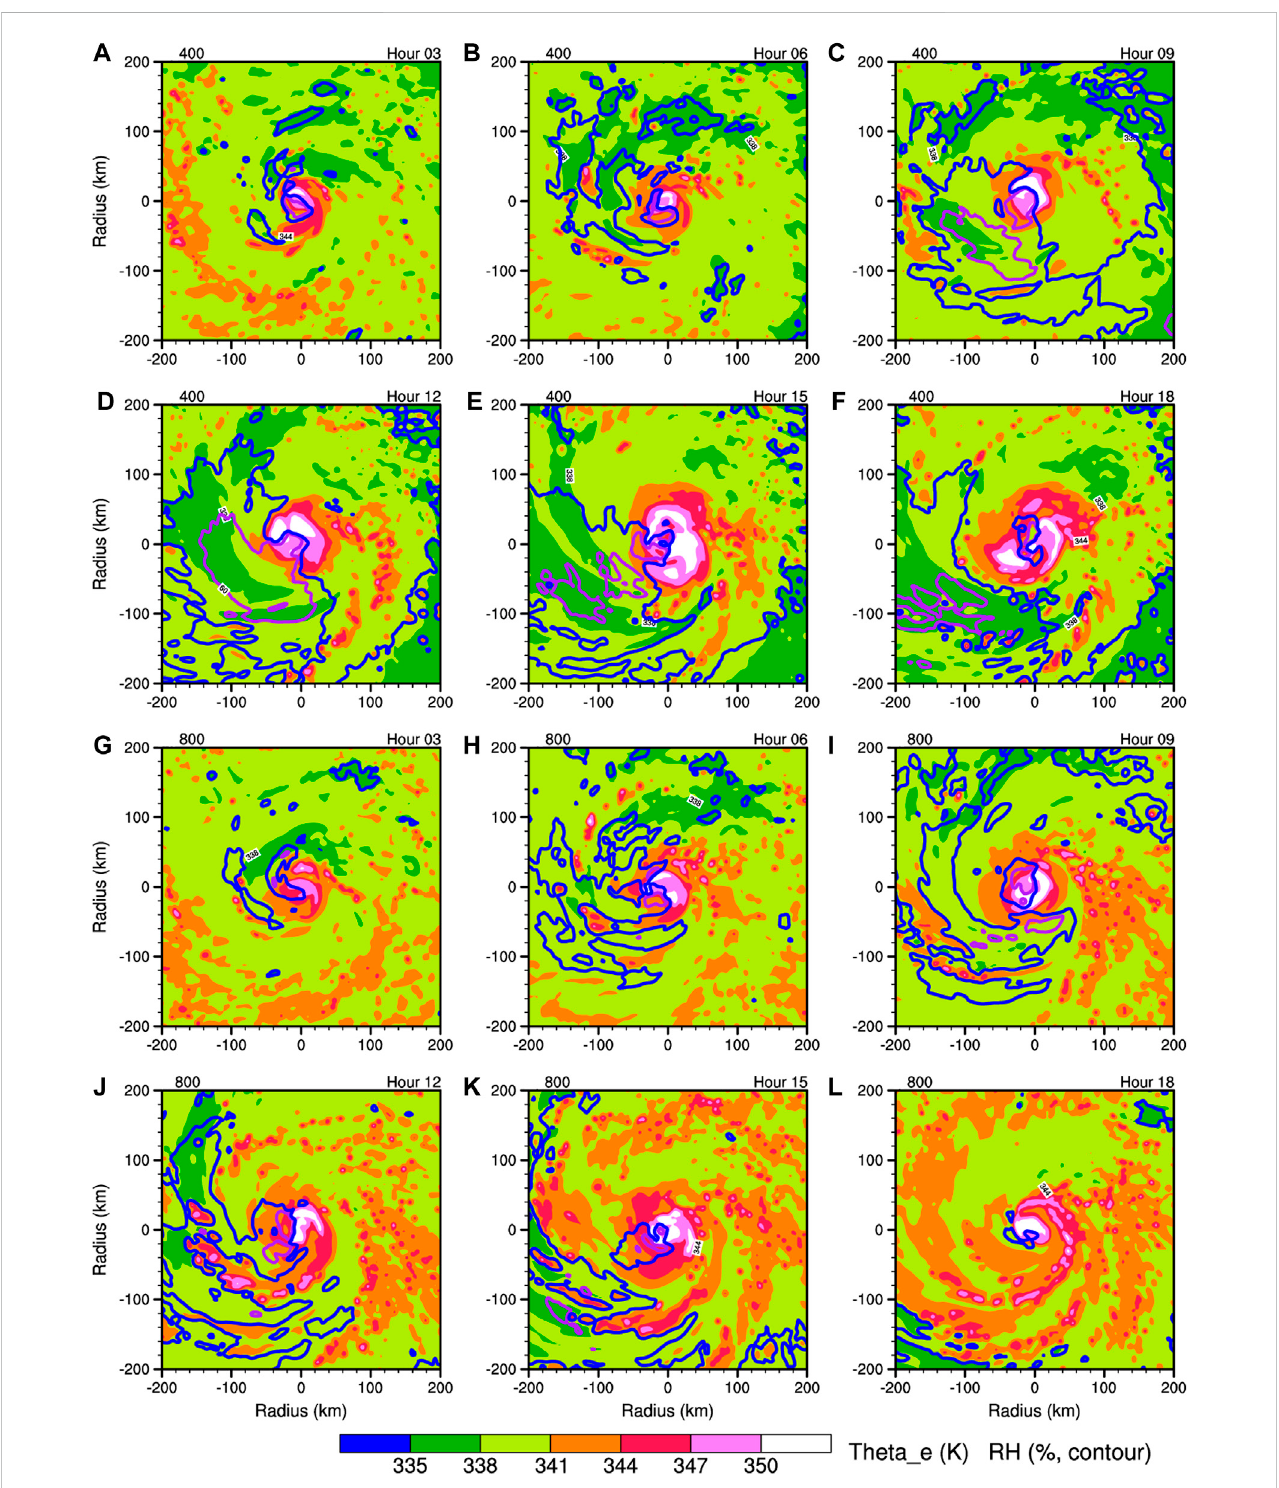
Evolution of θ e (shaded, K) andrelativehumidity(contour)at3 kmathour 3,6, 9,12,15,and 18.Purpleand bluecontoursare at60and70%,respectively. (A – F) Data from EXP400. (G – L) Data from EXP800.